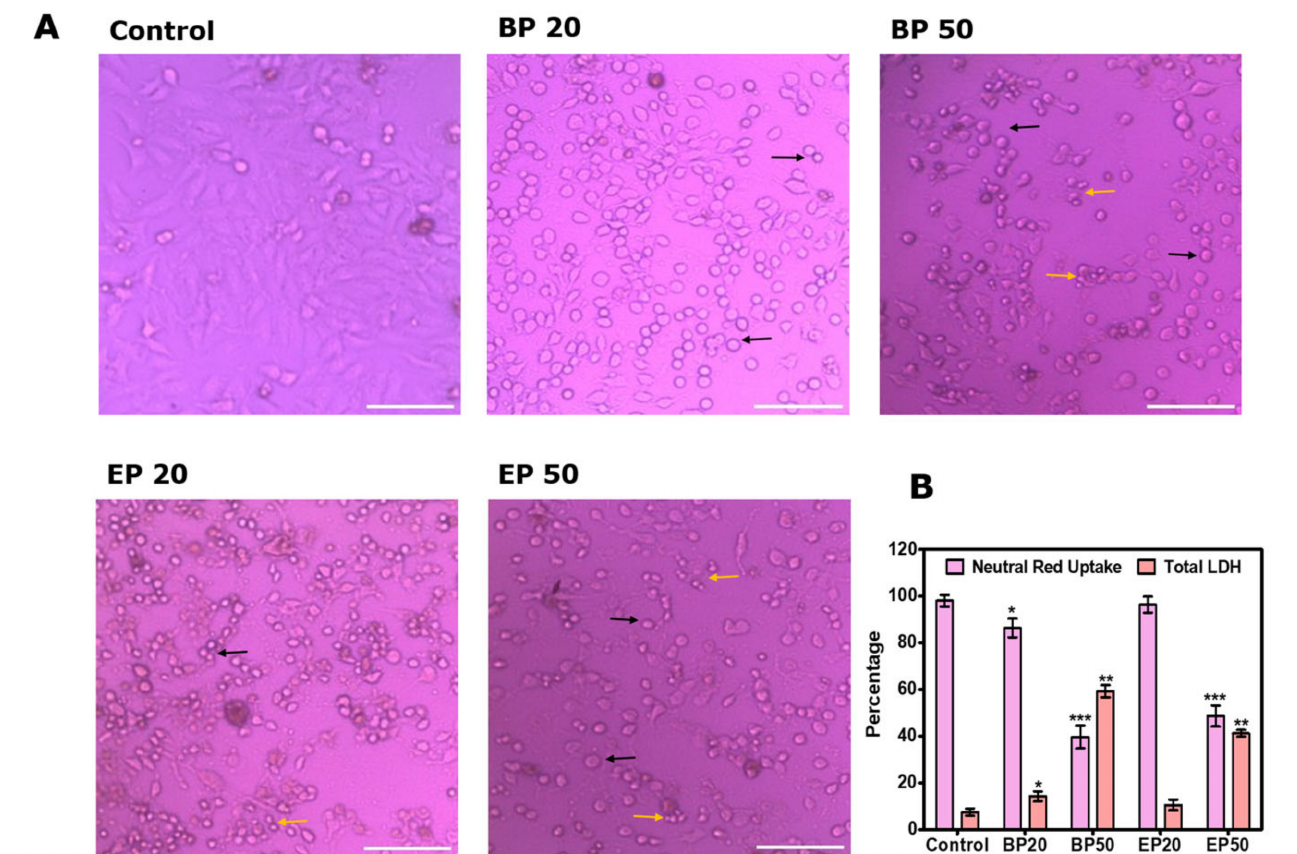
Figure 3. Cytotoxic effect of BP and EP on Hep-2 cells. ( A ) Morphological changes of the HEp2 cells after treatments with BP and EP at IC 20 and IC 50 concentrations. The cells were analyzed using a brightfield inverted microscope at 100 × magnification. Morphological changes such as cell rounding (indicated by a short black arrow) and cell shrinkage (indicated by a short yellow arrow) were observed with the BP and EP treatments. ( B ) Neutral red uptake (NRU) and total LDH release of the HEp2 cancer cells. Reduction of NRU and increase in LDH indicate the cytotoxic ability of analogs BP and EP. Data are expressed as mean ± SD of three independent experiments. * p < 0.05, ** p < 0.01, *** p < 0.001 significance difference between the control and treatment. Scale: 50 µ m. 2.3. Activation of Cellular Apoptosis by Hydroxyl-Containing BP and EP